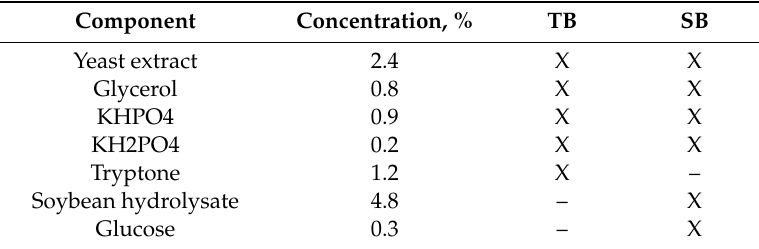
Table 2. Comparison of E. coli culture media.